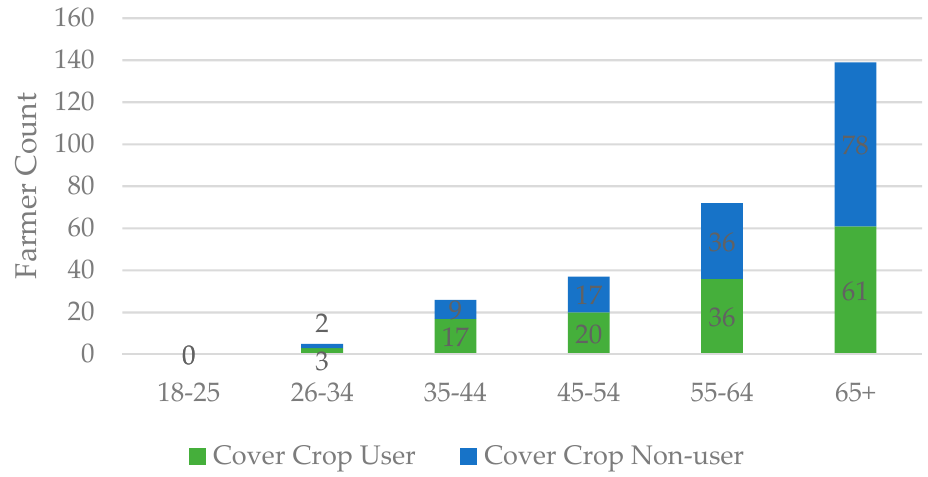
Figure 6. The distribution of respondents based on age ( p < 0.05).